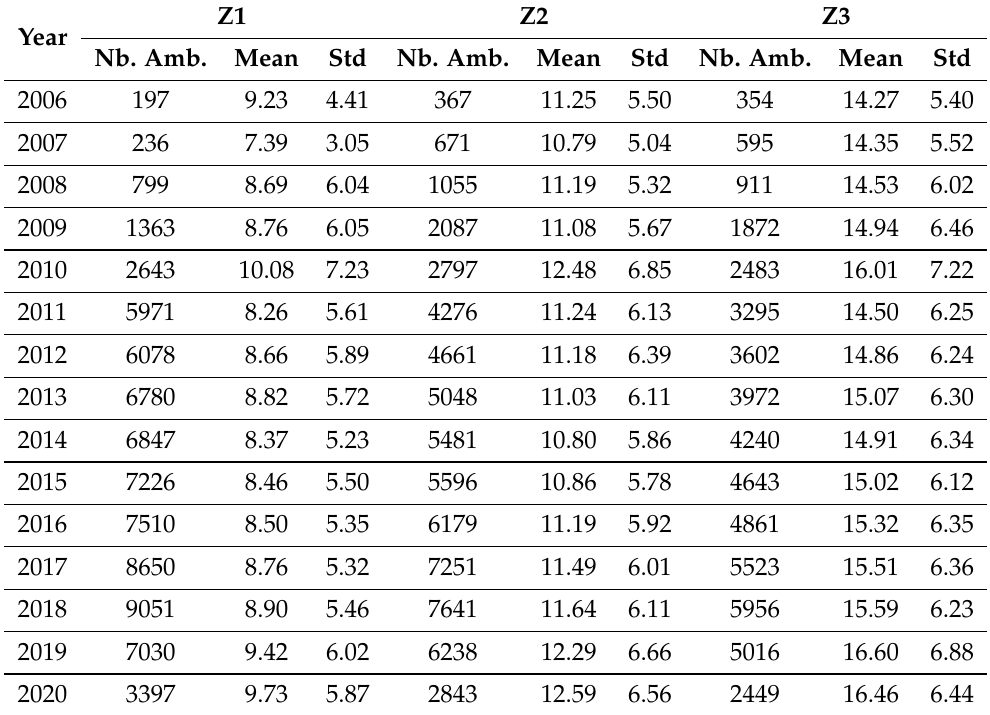
Table 1. Mean and std values for the ART variable and the total number of dispatched ambulances (Nb. Amb.) per year in zones Z1, Z2, and Z3, respectively. For 2020, we only consider cases of the first semester.